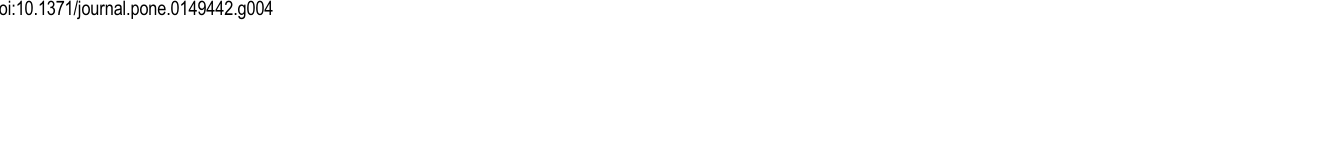
PLOS ONE | DOI:10.1371/journal.pone.0149442 February 19,